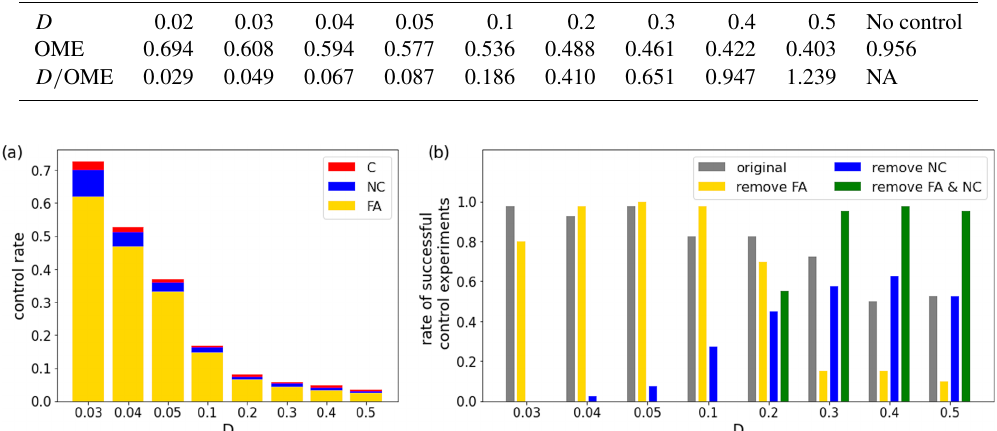
Figure 4. (a) Rates of the cases of C (red), FA (yellow), and NC (blue) for the successful control experiments with T = (cid:100) 4 T 0 (cid:101) and perturba- tions added to variables x , y , and z . The rates indicate the number of cases out of a total of 1000 DA cycles. (b) Rates of successful control experiments with T = (cid:100) 4 T 0 (cid:101) and perturbations added to variables x , y , and z for the original CSE (grey; cf. Fig. 3a), the CSE without apply- ing FA perturbations (yellow), the CSE without applying NC perturbations (blue), and the CSE without applying FA and NC perturbations